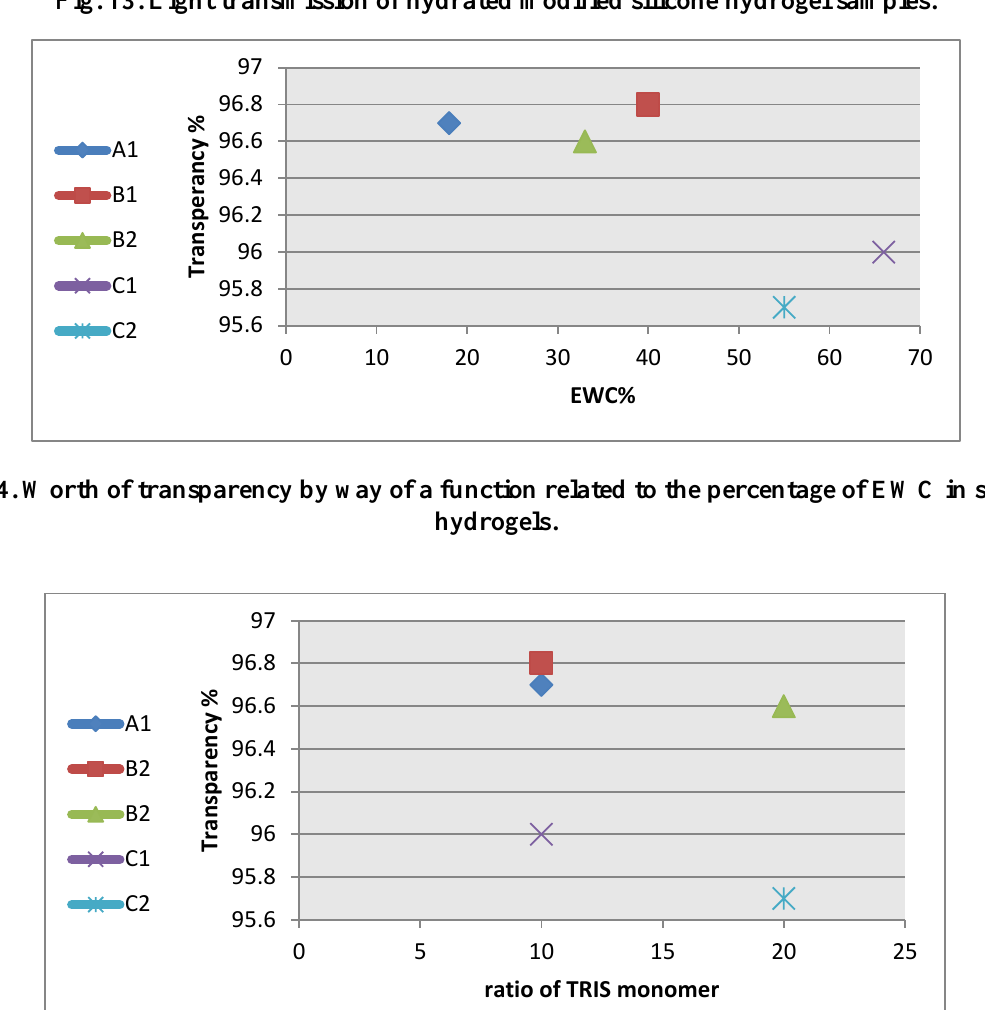
Fig. 13. Light transmission of hydrated modified silicone hydrogel samples.